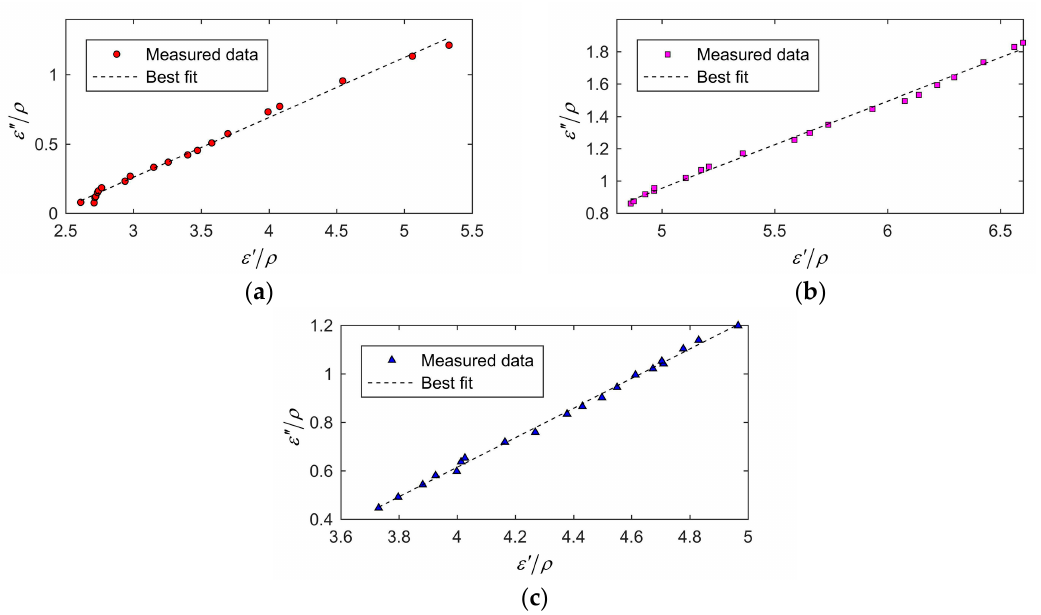
Figure 17. Linear regression analysis on the data: ( a ), wheat at 3.6 GHz; ( b ), rough rice at 4.0 GHz; ( c ), barley at 4.1 GHz.